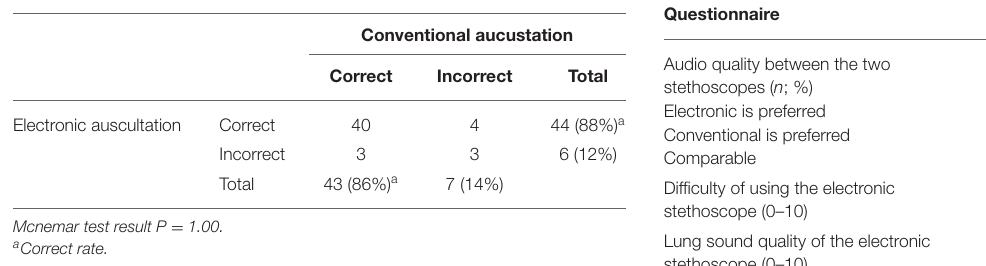
TABLE 3 | Correlation of lung ventilation detection through conventional and electronic auscultation.